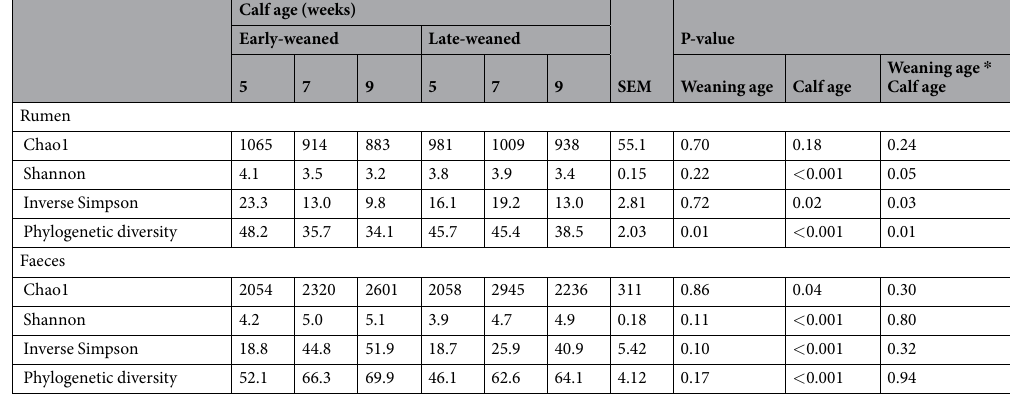
Table 1. Alpha diversity